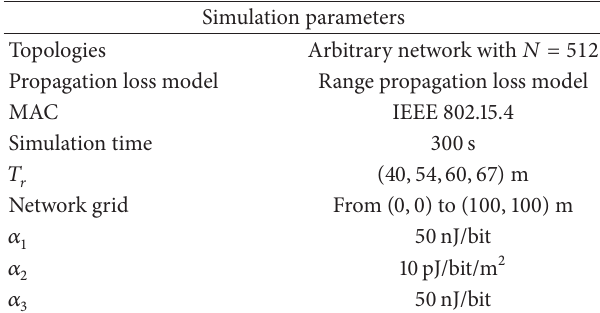
Table 2: The Simulation